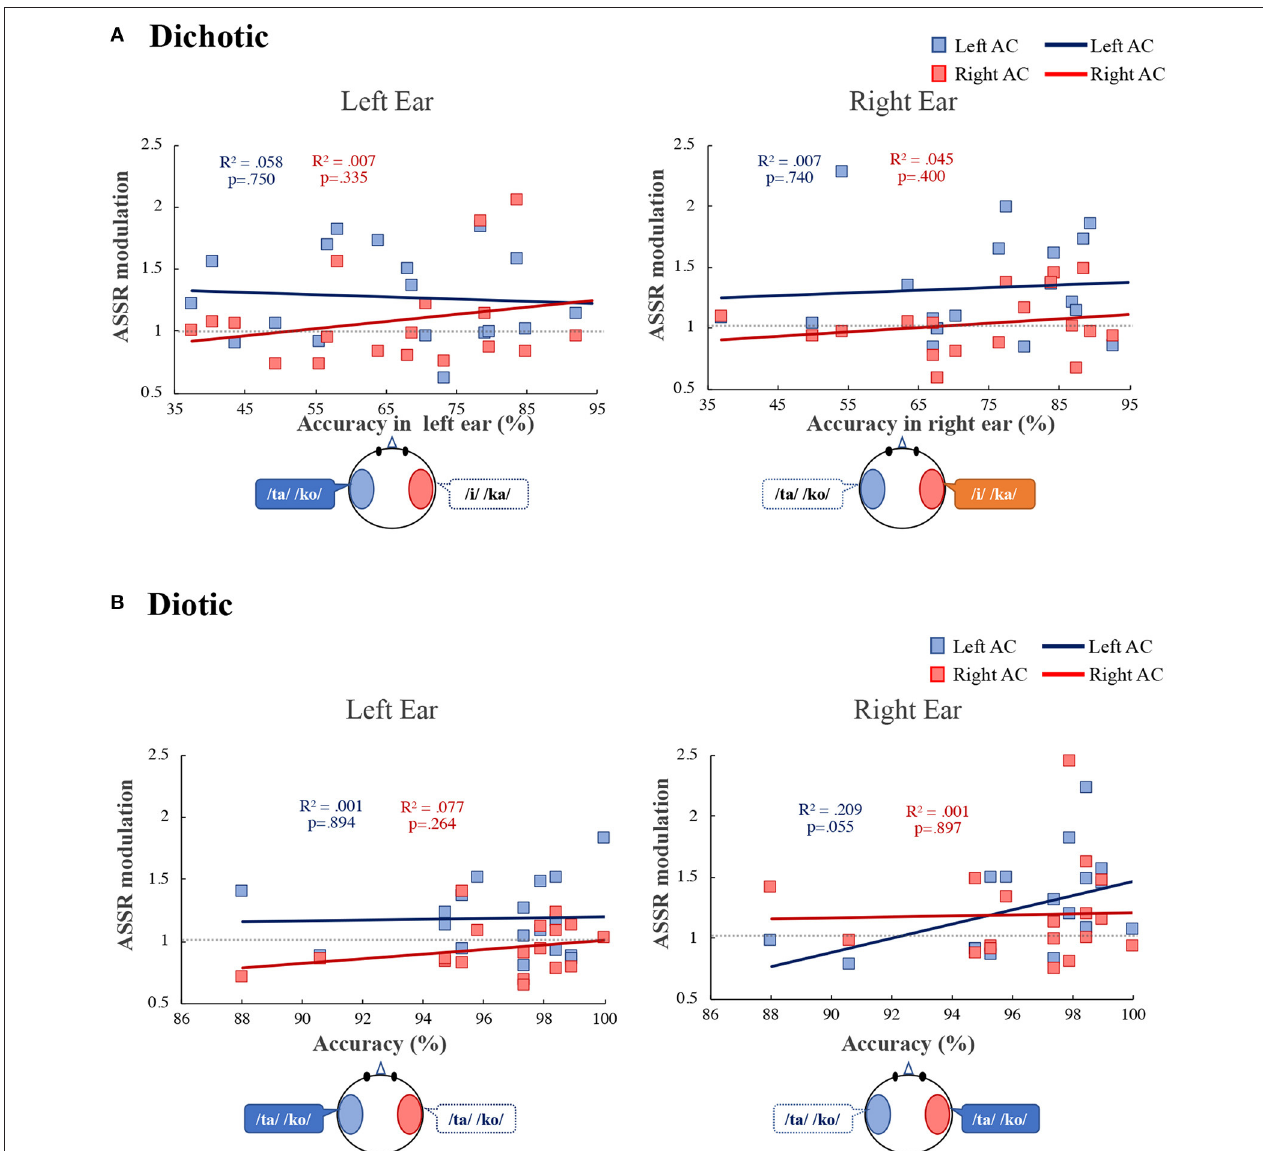
FIGURE 5 | Correlation between the accuracy and the ASSR modulation in the left (blue) and right (red) auditory cortex (Left AC or Right AC) to the left and right-ears during the dichotic listening (A) diotic listening (B) tasks. R 2 indicates determination coefficient. ASSR, auditory steady-state response; AC, auditory cortex.